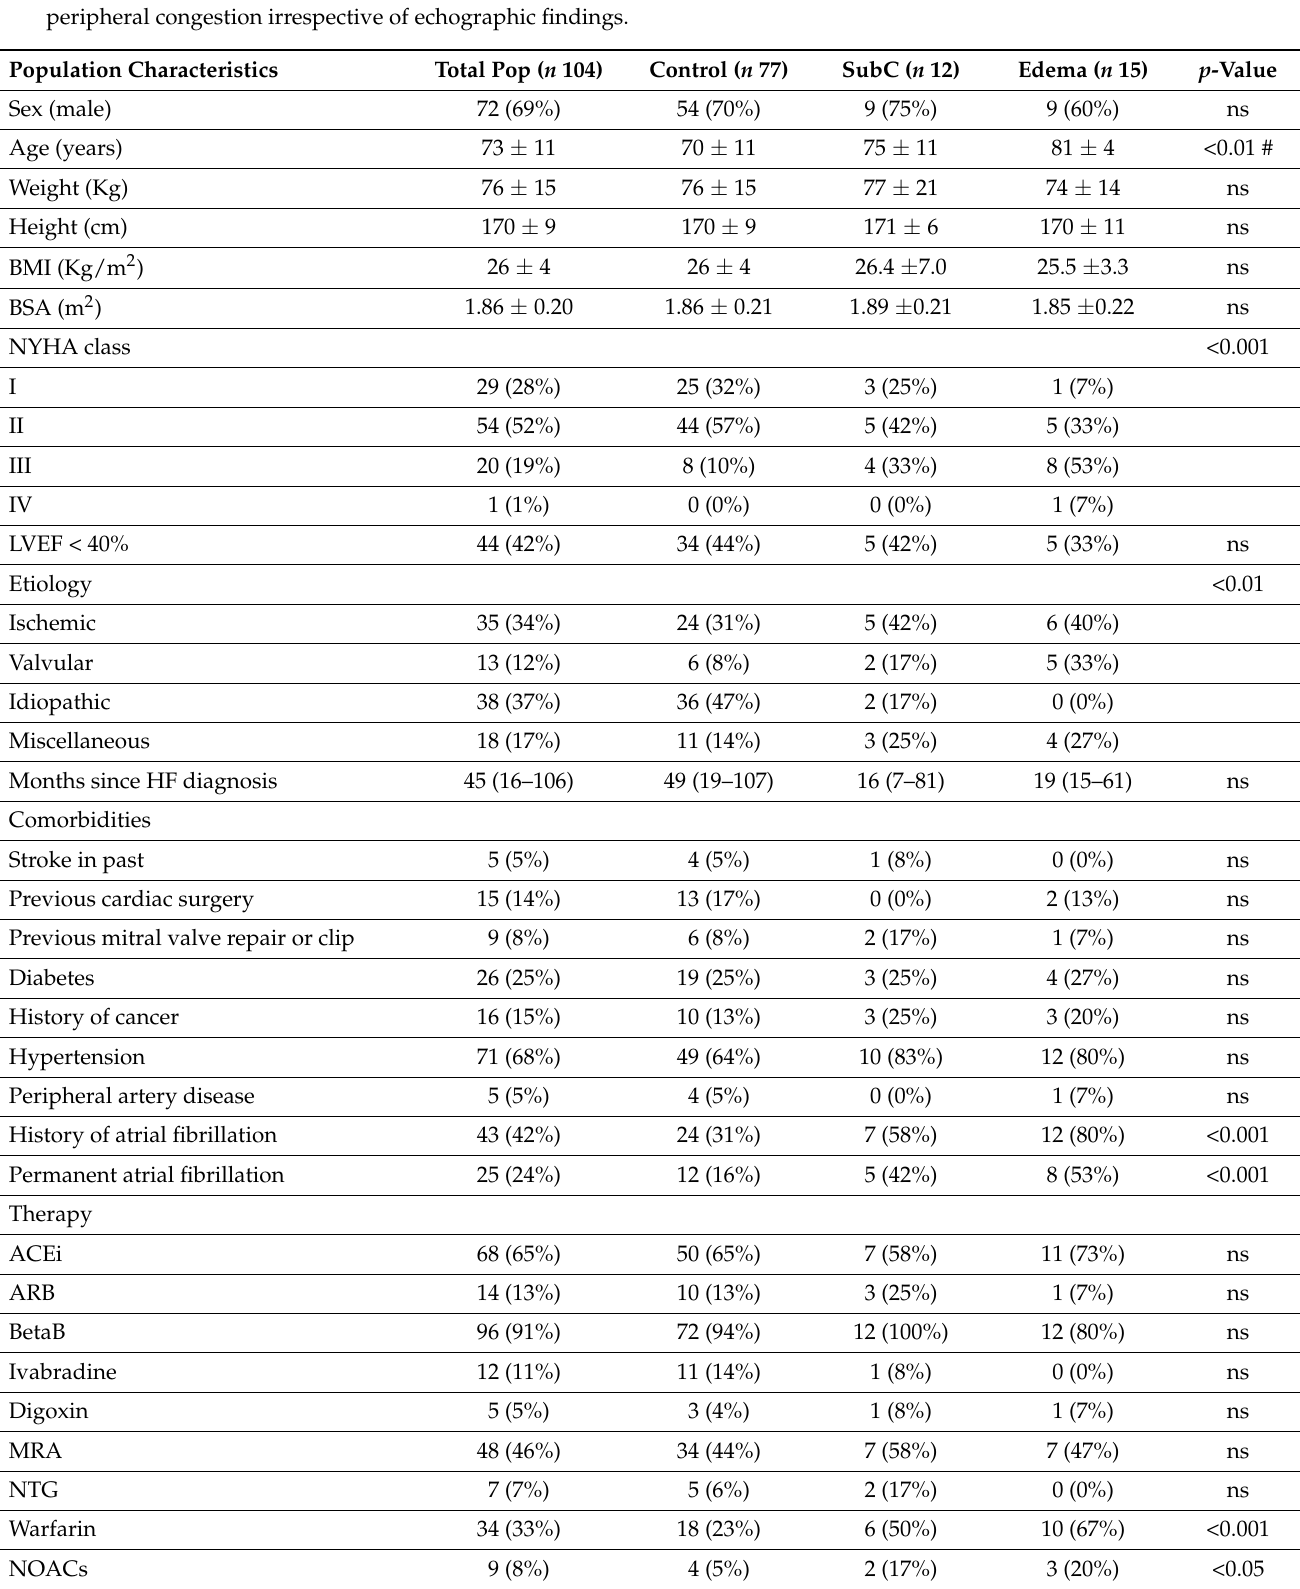
Table 1. Main clinical patients’ characteristics divided into subgroups under comparison. Group “Control”: patients without clinical signs of peripheral congestion nor echographic signs of congestion. Group “SubC” (Sub Clinical congestion): patients with echographic signs of congestion without peripheral clinical congestion. Group “Edema”: patients with peripheral congestion irrespective of echographic